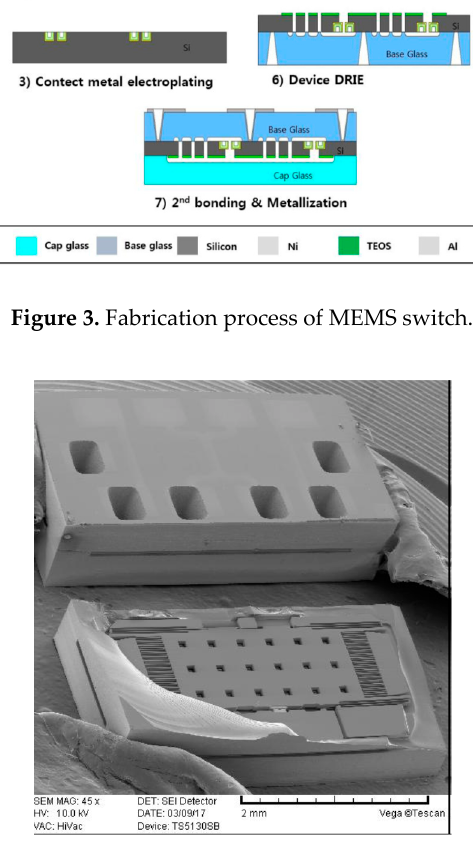
Figure 4. SEM image of MEMS